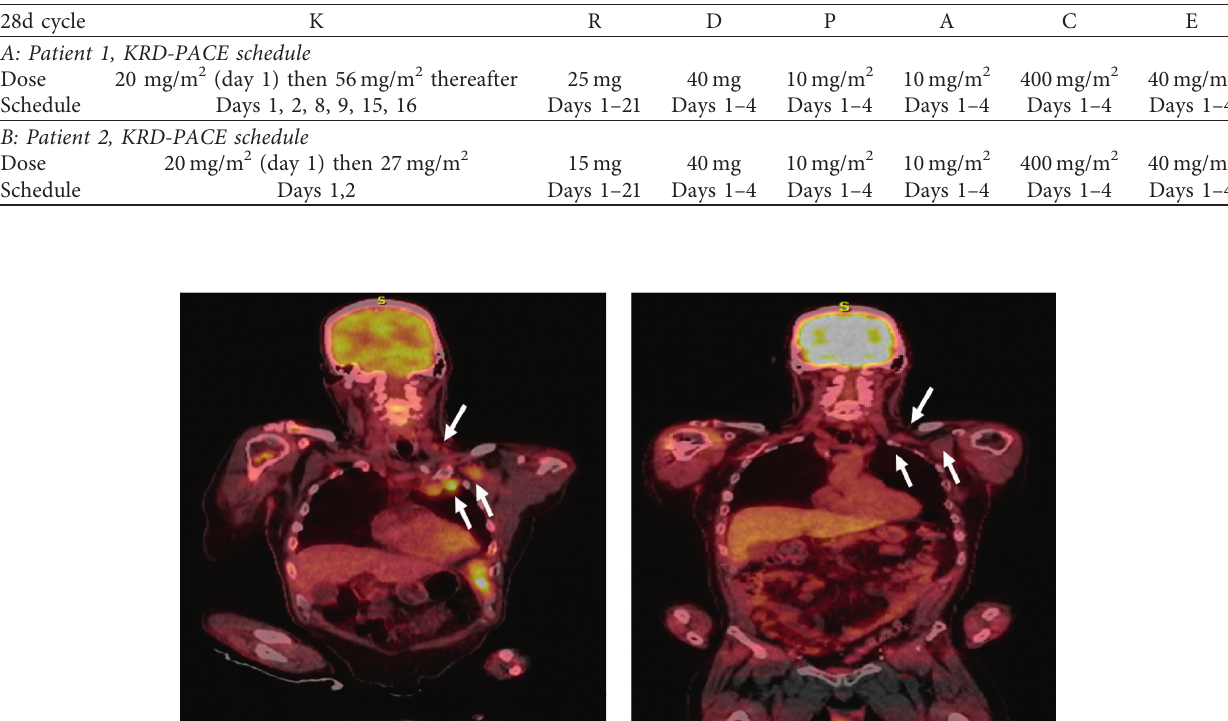
Table 2: KRD-PACE dosing schedule for patient 1 and KRD-PACE dosing schedule for patient